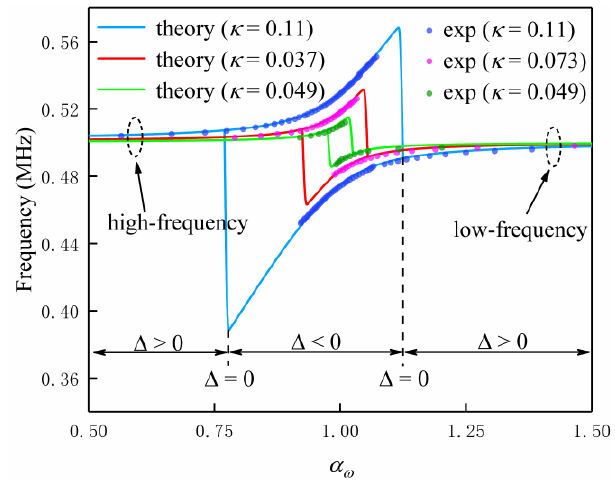
Figure 8. Operating frequency of the system versus α ω at detuning.